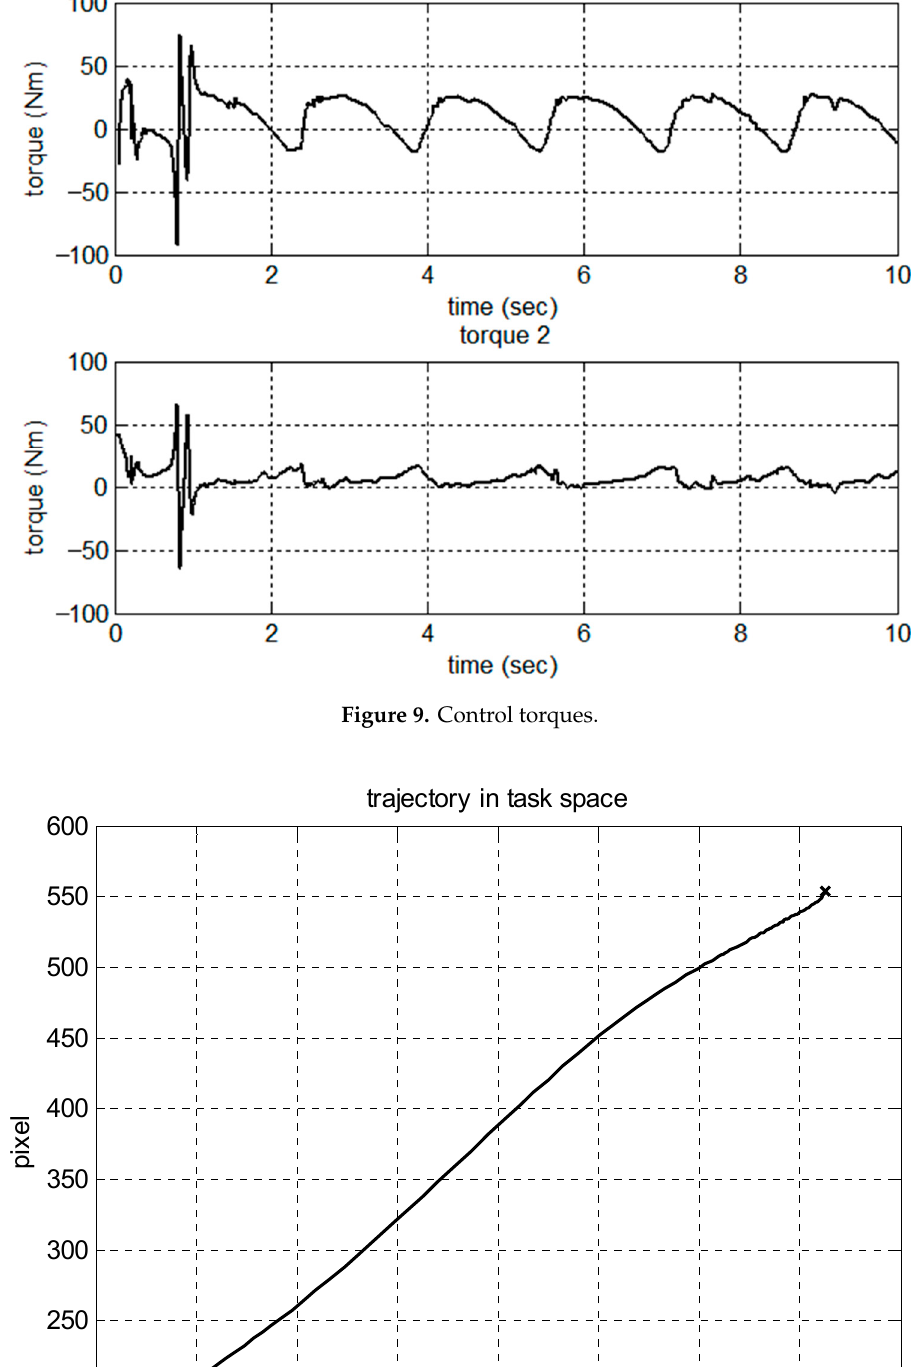
Figure 10. Trajectories in the task space.